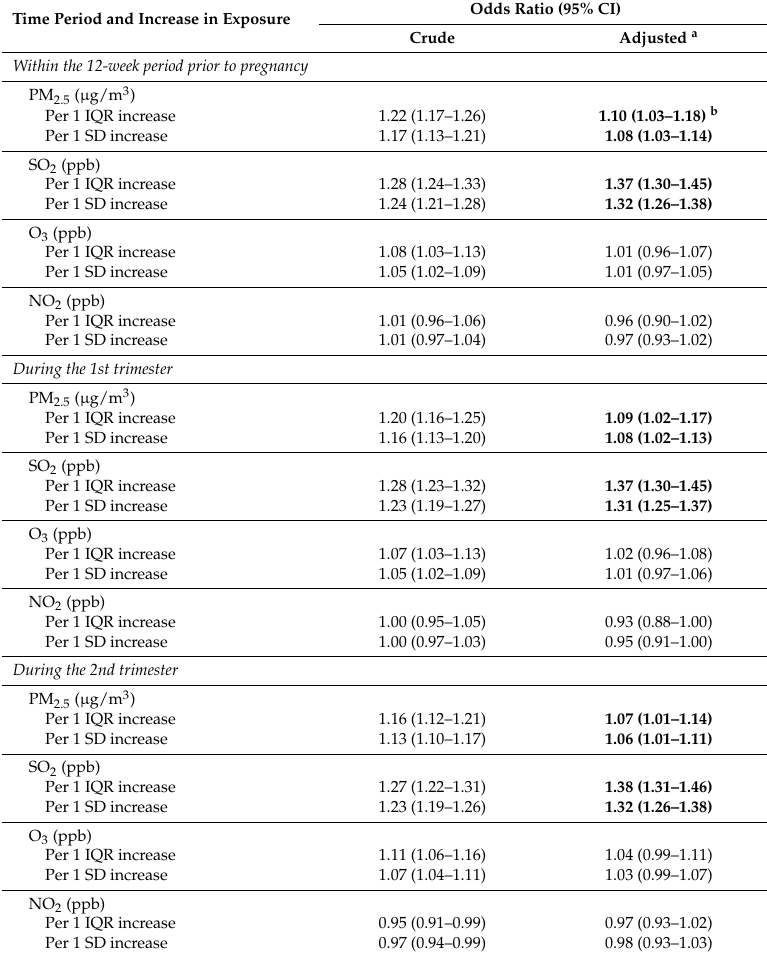
Figure 1. Pre- and post-pregnancy average daily exposure to various air pollutants for cases and controls. Note: For the graph of reach pollutant. － : Min. and Max.; × : 1% and 99%; : Mean. The 12-week period before pregnancy ( left ); The 1st trimester ( middle ); The 2nd trimester ( right ). Table 2 shows crude and adjusted OR of GDM in association with pre- and post-pregnancy exposures to various air pollutants. Table 2. Crude and adjusted odds ratio of gestational diabetes mellitus in association with various air pollutants exposure before and after pregnancy.